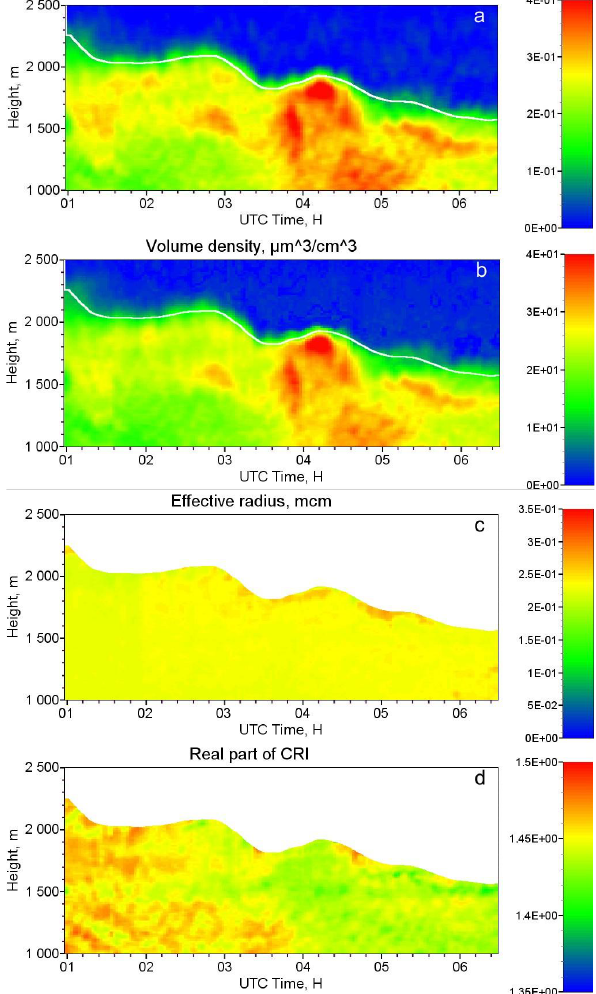
Fig. 8. Spatio-temporal distribution of (a) particle extinction at 355 nm calculated from the Raman nitrogen signal together with (b) particle volume, (c) effective radius and (d) the real part of the complex refractive index on 22 July 2011.